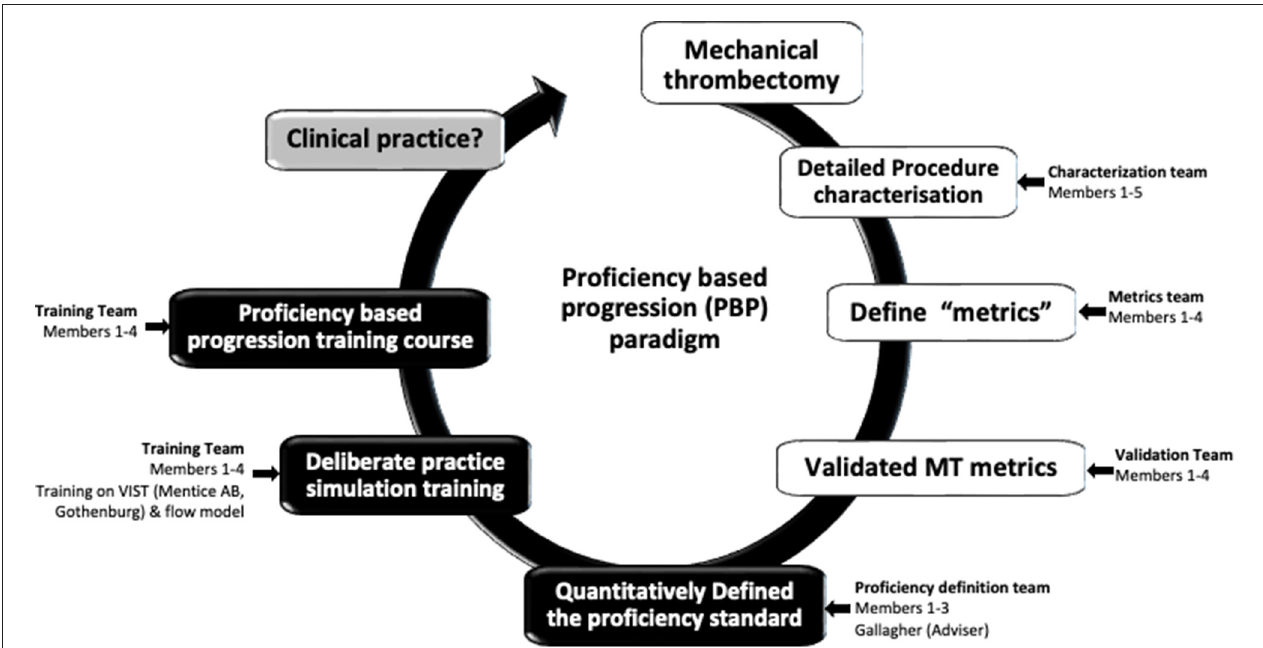
FIGURE 1 | The Proficiency based progression (PBP) metric development, validation and training paradigm (Crossley, 1 Holtmansspötter, 2 Liebig, 3 (Interventional Neuro Radiologists); Gallagher 4 (Behavioural Scientist); Lindkvist 5 (VR Sim engineer